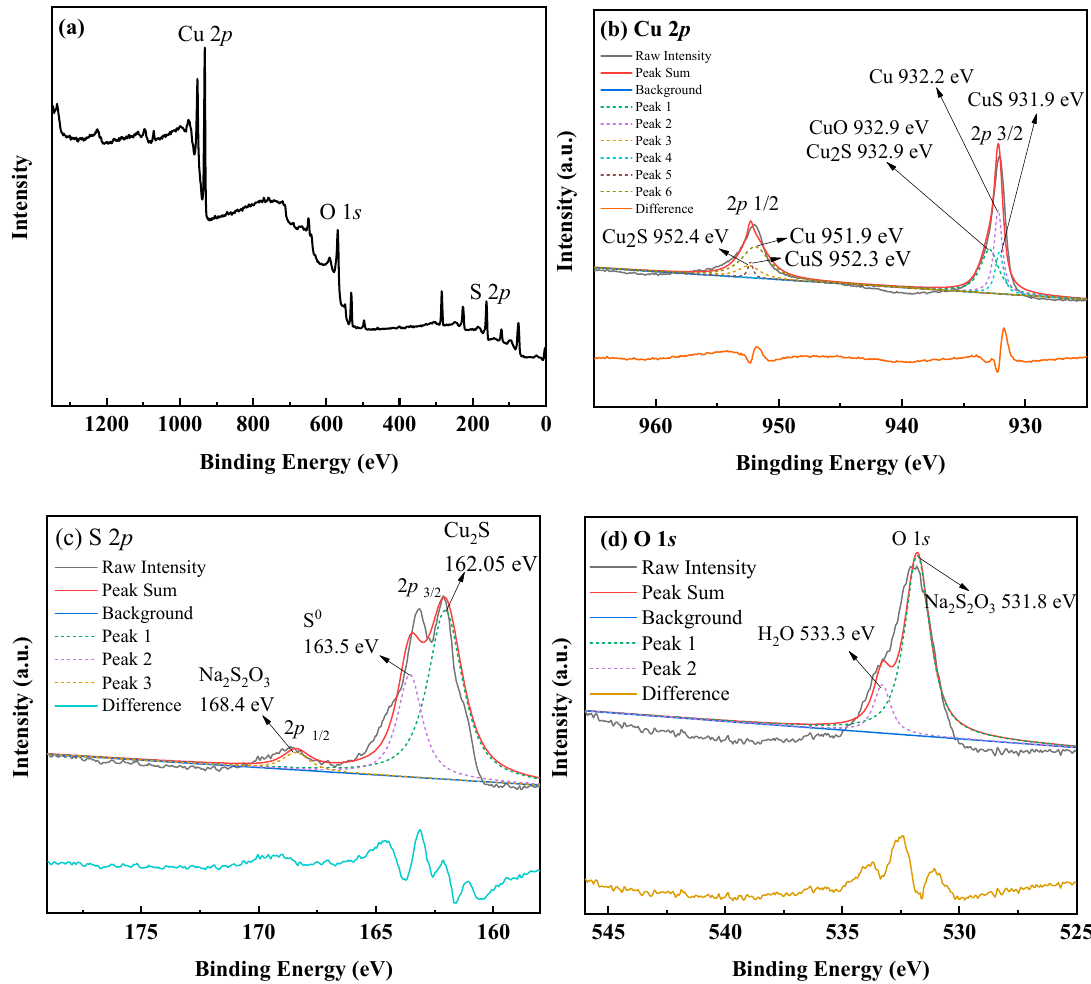
Figure 7. Deconvoluted XPS spectra for the photoproducts ( a ) survey spectrum; ( b ) Cu 2 p spectrum; ( c ) S 2 p spectrum; ( d ) O 1 s spectrum ([Cu] = 50 mg/L, [S 2 O 32 − ] = 0.1 mol/L, 298 K, uncontrolled pH).